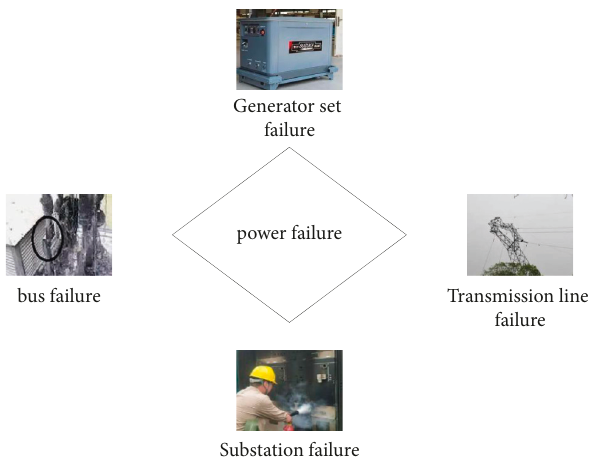
Figure 6: Several common power